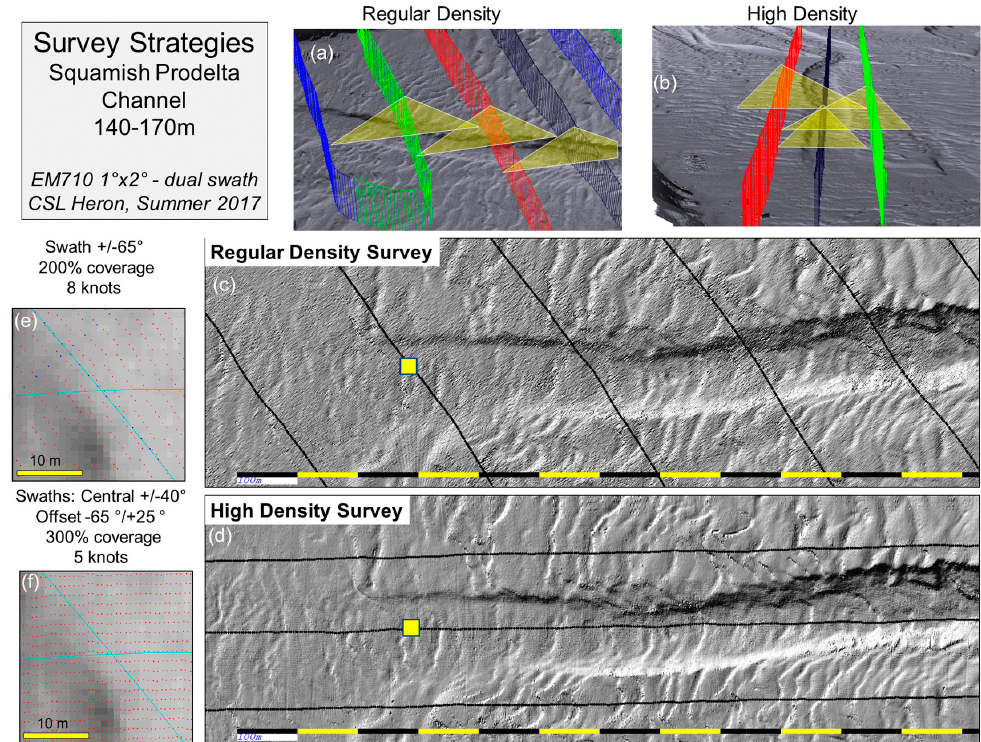
Figure 13. Impact of simultaneously changing angular sector, overlap and survey speed. Seabed channel in ~140–170 m of water surveyed twice using the same sensor (EM710 1° × 2°). Regular 200% coverage using ±65° at 8 knots, and ±40° with 300% at 5 knots. ( a , b ) Illustrate the two survey geometries; ( c , d ) show the resulting bedform definition (black lines show ship-tracks) and ( e , f ) reveal the resulting sounding density (zoom of yellow box in ( c , d )).